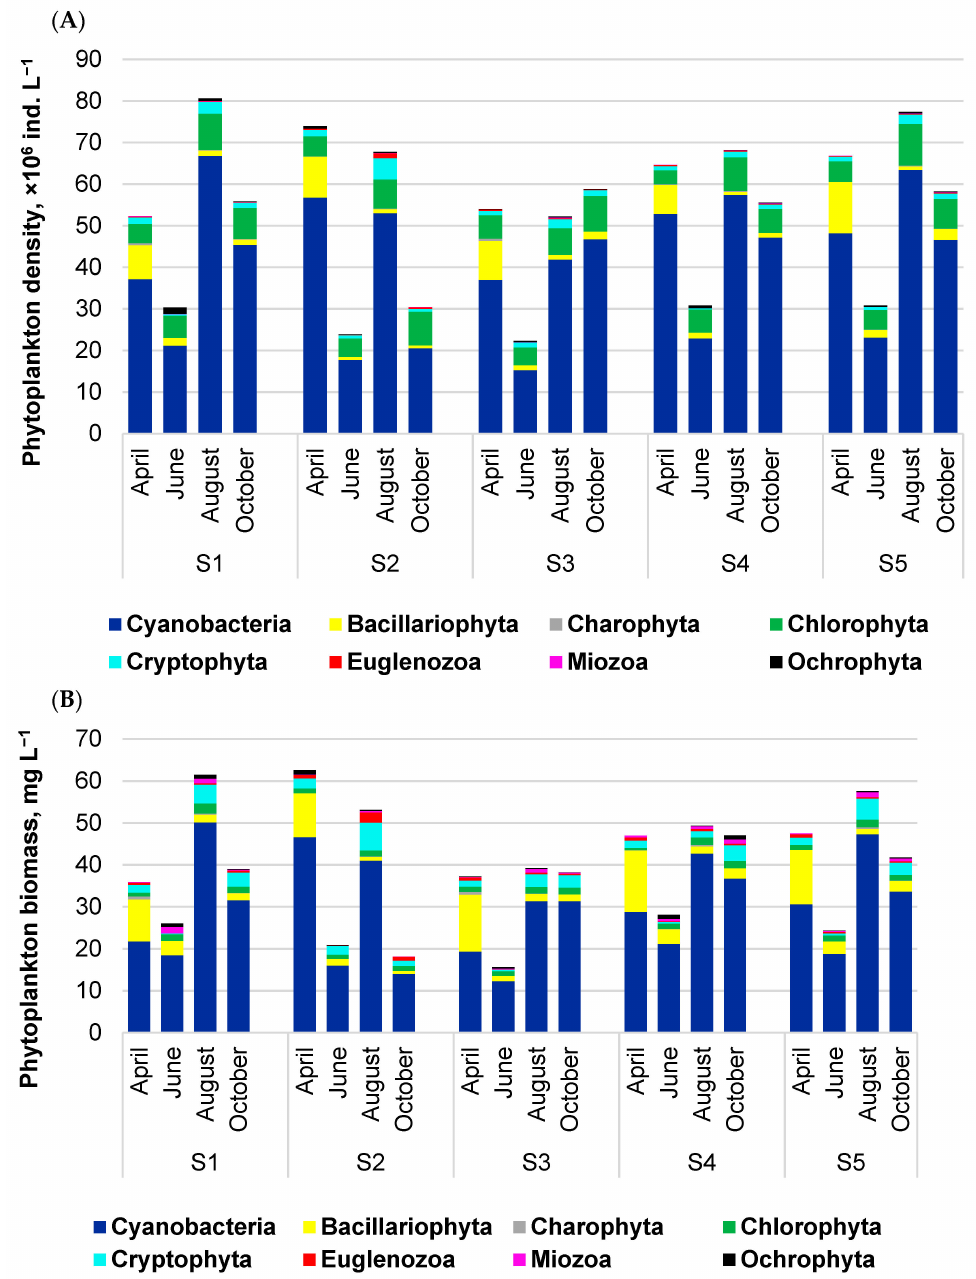
Figure 4. Spatial distribution of phytoplankton density ( A ) and biomass ( B ) in surface waters of Lake Sztynorckie. Sampling sites: S1—profundal zone; S2—inflow zone; S3—channel zone; S4—fuel zone; S5—mooring